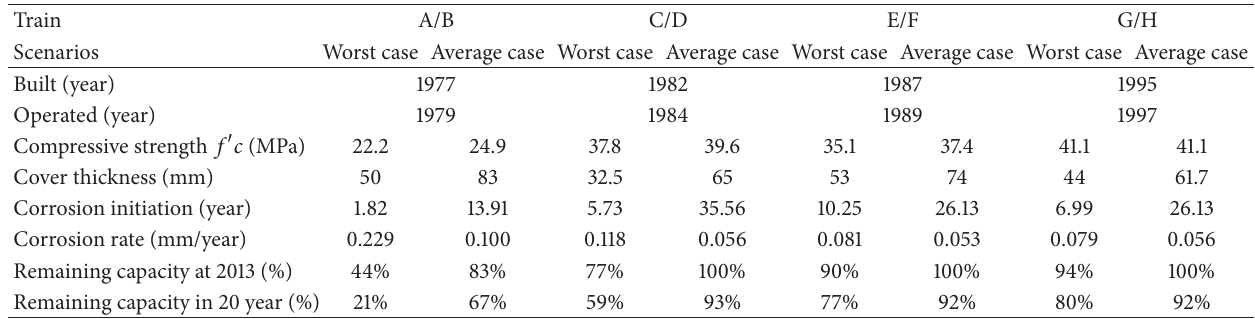
Table 9: Corrosion initiation time and concrete deterioration rate.